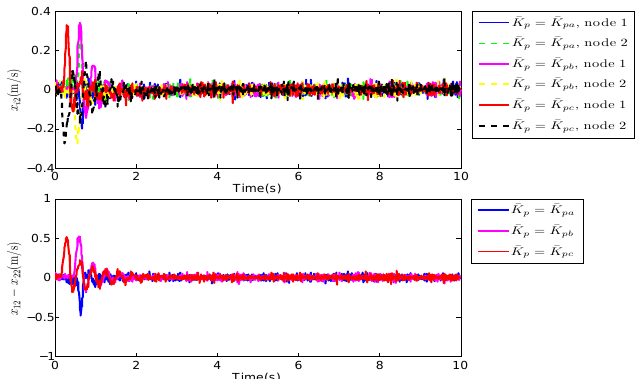
Figure 13. The compared velocity response results of the three state-feedback matrices using pole placement in the experiment.